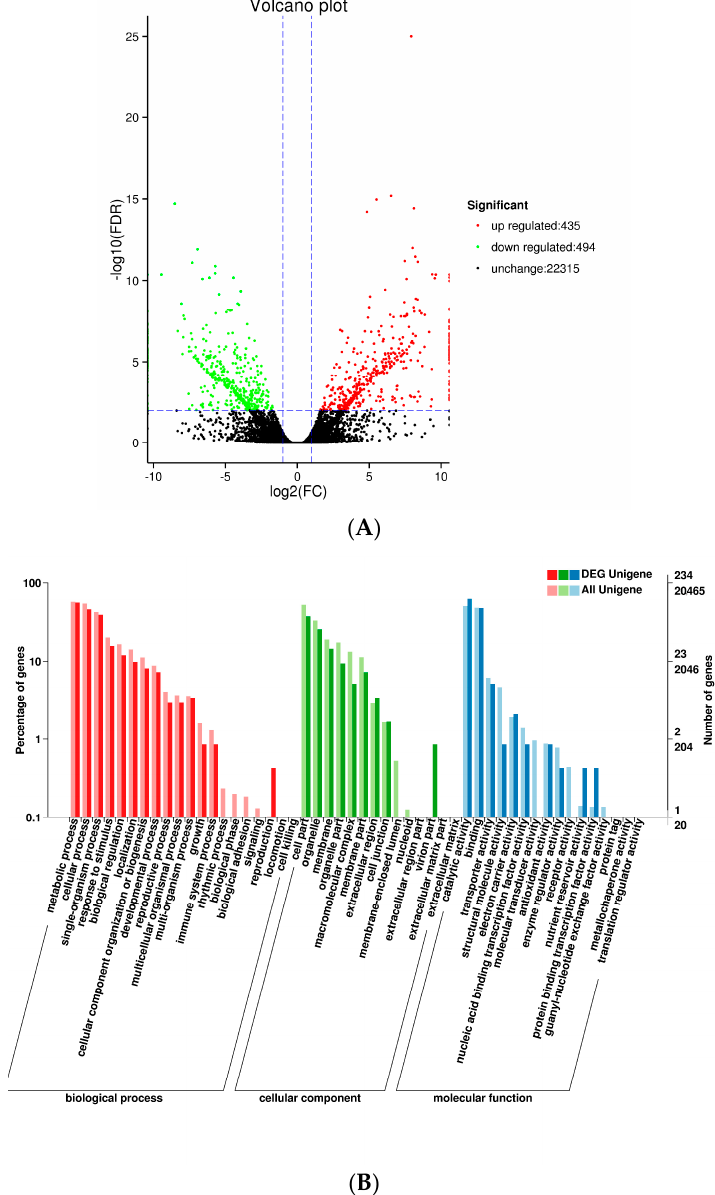
Figure 5. Volcanic map and GO classifications of differentially expressed genes. ( A ) Volcanic plot map of unigenes; ( B ) GO classifications of DEG unigenes. FDR: false discovery rate; DEG: differentially expressed gene.